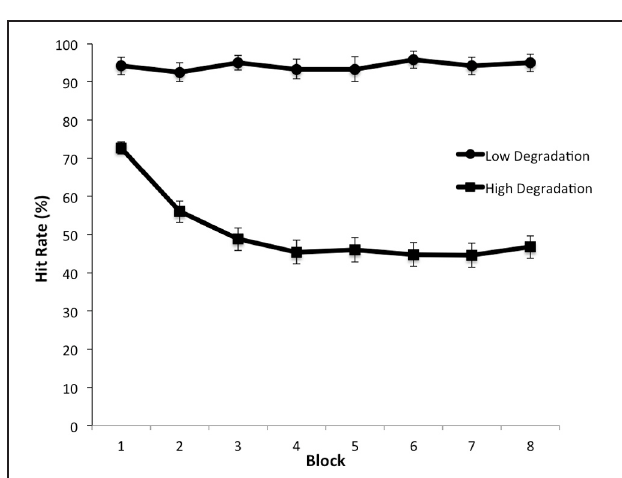
FIGURE 4 | Brain areas involved in action understanding. IFG, inferior frontal gyrus; IPS, intraparietal sulcus; MT, middle temporal gyrus; STS, superior temporal sulcus; vPMC, ventral premotor